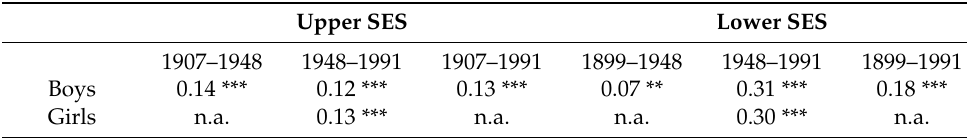
Table 4. Decennial HAZ growth, boys and girls aged 6–18, upper vs. lower SES. Upper SES